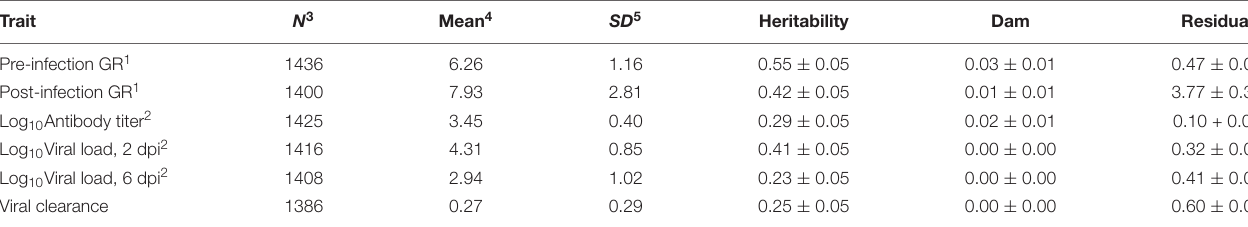
TABLE 2 | Trait estimates ( ± SE) of variance components in the Ghana local chicken ecotypes population. Trait